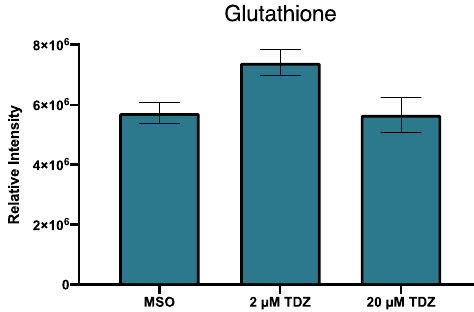
Figure 2. Relative expression of metabolite putatively identified as glutahione in African violet petioles treated with 0, 2 or 20 µM thidiazuron. Bars represent mean, with error bars represent standard error margins. Biomolecules 2020 , 10 , x